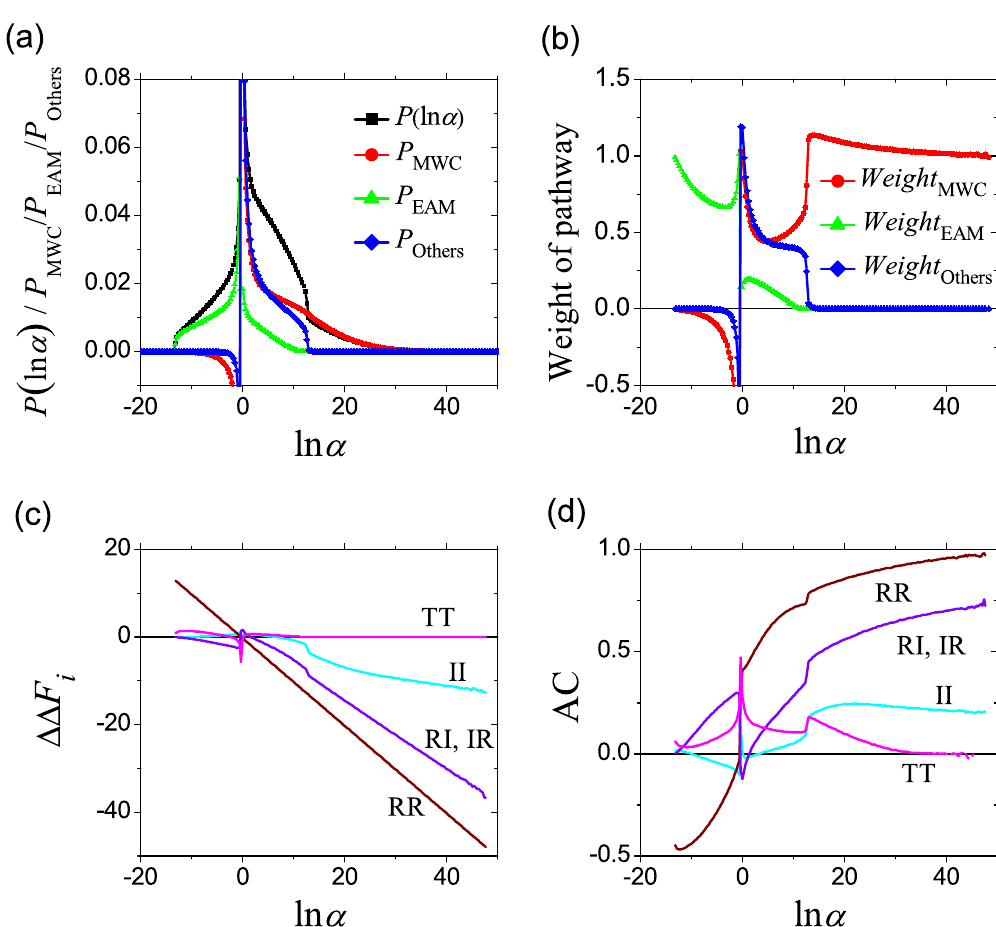
Fig 9. Analysis results with other measures of allostery. (a) Distribution of ln α where α is the thermodynamic allosteric efficacy defined in Eq (13), as well as the capacity of three pathways. (b) The average weights of pathways as functions of ln α . (c) The average thermodynamic coupling function [ ΔΔ F i , as defined in Eq (15), and in a unit of RT ] at some states as functions of ln α . (d) The average normalized allosteric coupling [ AC , as defined in Eq (16)] of some states as functions of ln α . The variation range ( Δ G max ) for free-energy parameters is 8